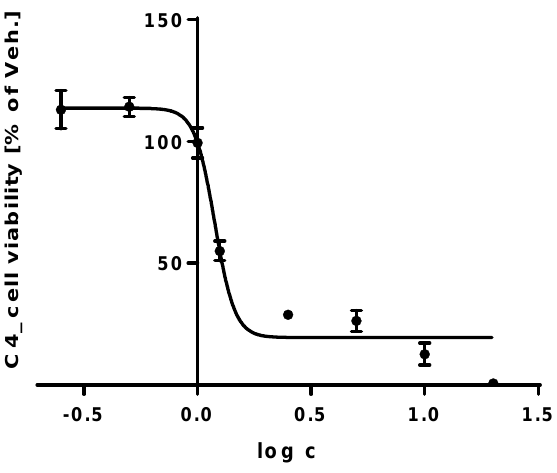
Figure 2. Effect of compound 4 on the viability of human leukemic monocytes THP - 1. The cells were treated with compound 4 dissolved in DMSO at increasing concentrations 0.25 – 0.5 –1– 1.25 – 2.5 – 5 –10– 20 μM or with only the vehicle and their viability was measured after 24 h. Untreated control cells were used to verify the non- toxic effect of the vehicle. The viability of the cells treated with compound 4 was compared to that of the vehicle- treated cells. The results are expressed as the mean ± SE for three independent ass ays. The concentration of DMSO never exceeded 0.1%.